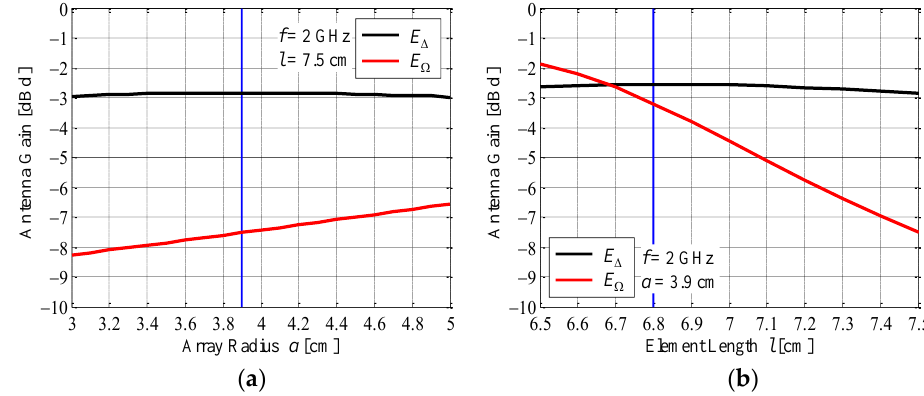
Figure 5. Radiation gain of the AOA estimation function in the proposed antenna: ( a ) array radius and ( b ) element length.